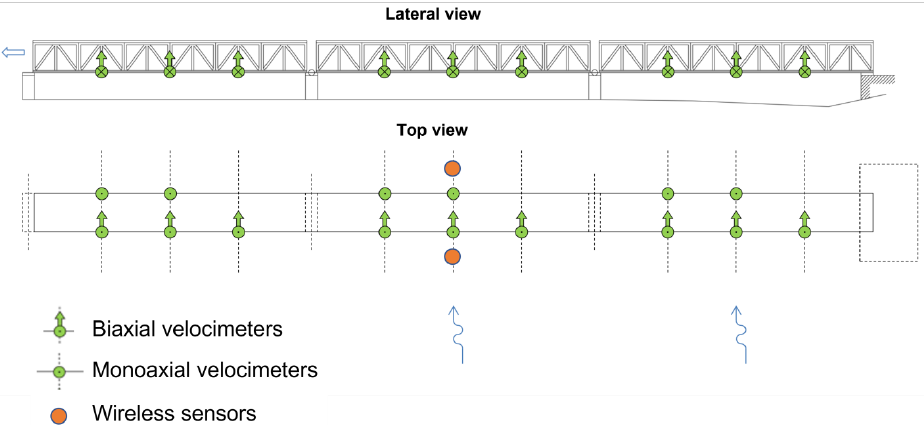
Figure 5. Schematic set-up of the wired velocimeters forming the permanent monitoring system.